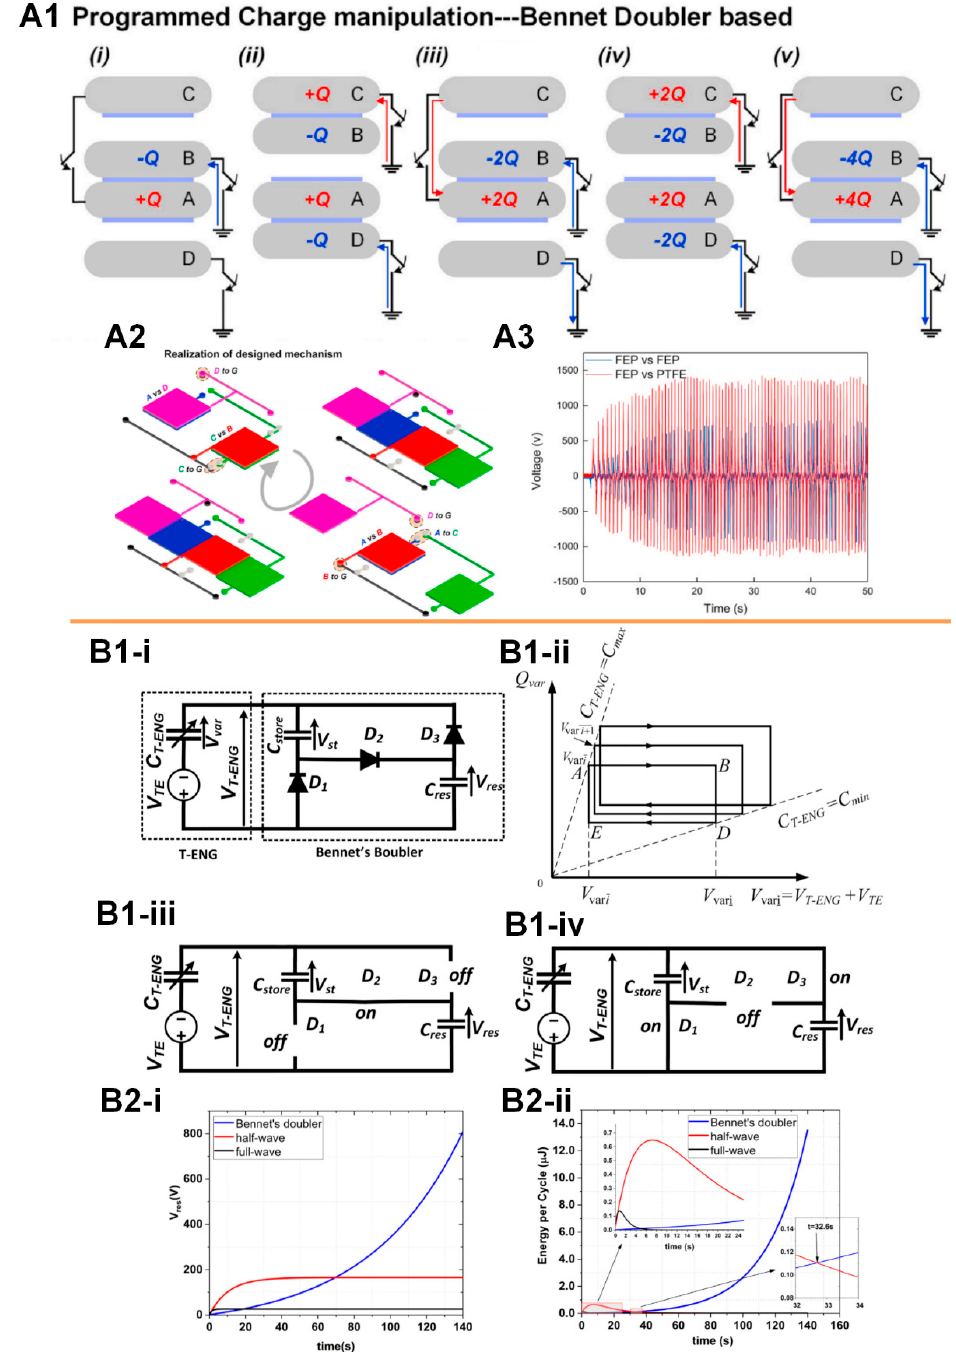
Figure 6. The Bennet’s doubler for the output amplification of TENG devices. ( A ) The mechanism of Bennet’s doubler and its mechanical realization in a TENG device: ( A1 ) The mechanism of the bennet doubler based TENG device; ( A2 ) The physical realization of the bennet doubler based TENG device in a sliding mode; ( A3 ) The typical voltage output of the bennet doubler based TENG device with different surface materials, showing that the amplitude of the voltage gradually saturates at the maximum value. Reproduced with permission from [94]. Copyright 2020 Elsevier; ( B ) The Bennet’s doubler conditioning circuit used for the output power amplification of TENG devices: ( B1 ) The principle of the bennet doubler conditioning circuit; ( B2 ) The typical output voltage ( i ) and energy ( ii ) of a TENG device with the amplification of the bennet doubler conditioning circuit. Reproduced with permission from [90]. Copyright 2018 Elsevier.